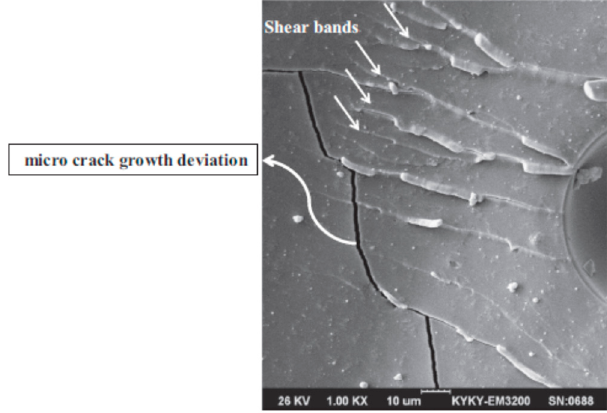
Figure 7. Micro-crack growth deviation in epoxy adhesive reinforced with MWCNTs. Reprinted with permission [38].